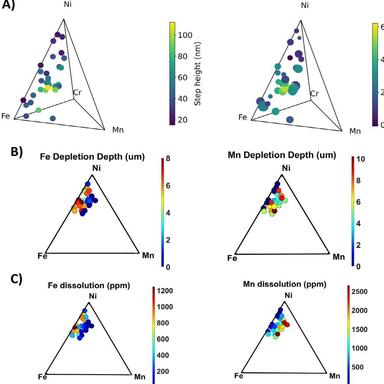
(a) Gibbs tetrahedra showing the step height and the hardening as function of composition in the CrFeMnNi CCA system. Note that the spheres volume in the hardening tetrahedron is related to the observed standard deviation. (b) ternary FeMnNi diagrams showing the Fe and Mn depletions depths for 25 different alloys and (c) ternary FeMnNi diagrams showing the Fe and Mn dissolved in the salt droplet for 25 different alloys.